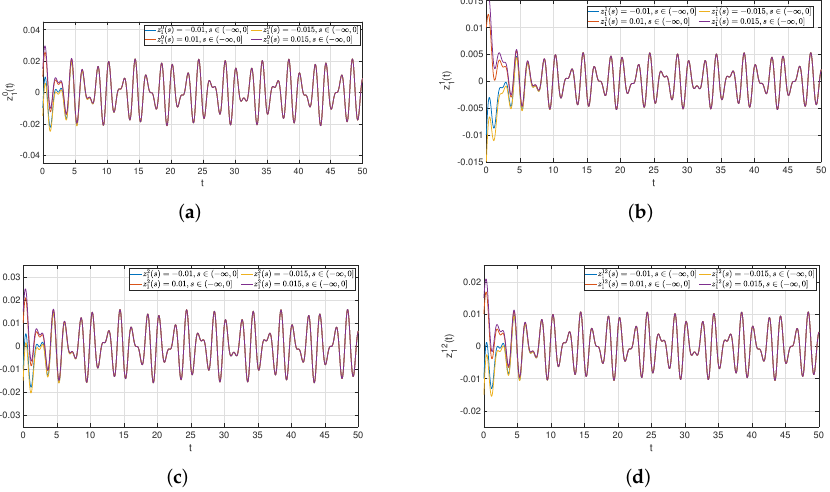
( t ) , z 1 ( t ) , z 2 ( t ) , z 12 ( t ) of system (1) with different initial values. ( a ) z 0 1 1 1 1 with different initial values; ( c ) z 2 1